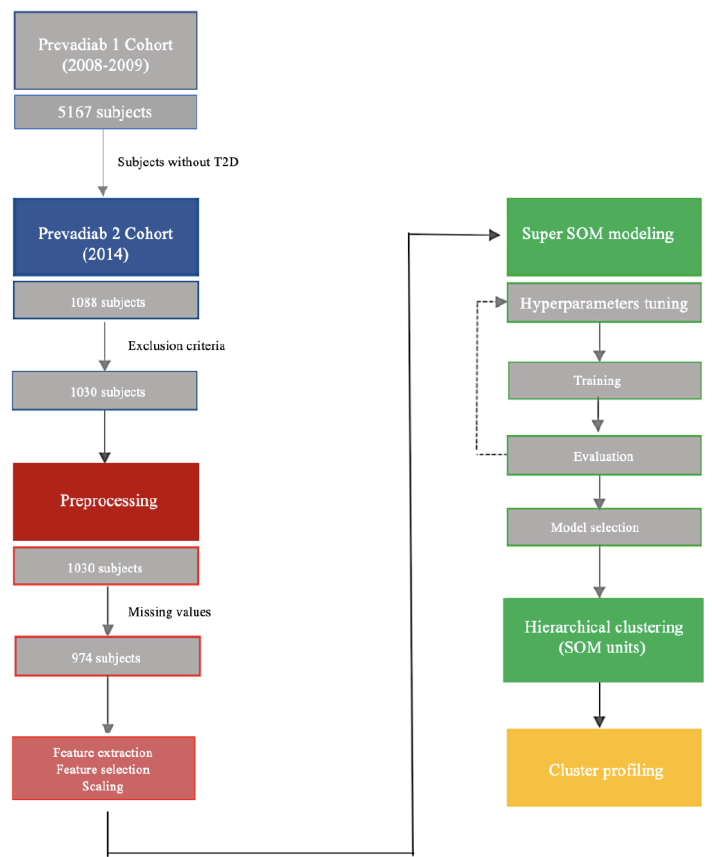
Figure 1. Methodology flowchart. In 2014, 1088 subjects from the PREVADIAB1 study without T2D in 2008–2009, were reevaluated 5 years later (PREVADIAB 2 cohort). After the application of exclusion criteria and preprocessing the data we performed a cluster analysis of 974 subjects. Finally, we profiled the clusters with several metabolic parameters. T2D-Type 2 Diabetes; SOM-Self-Organizing Map.